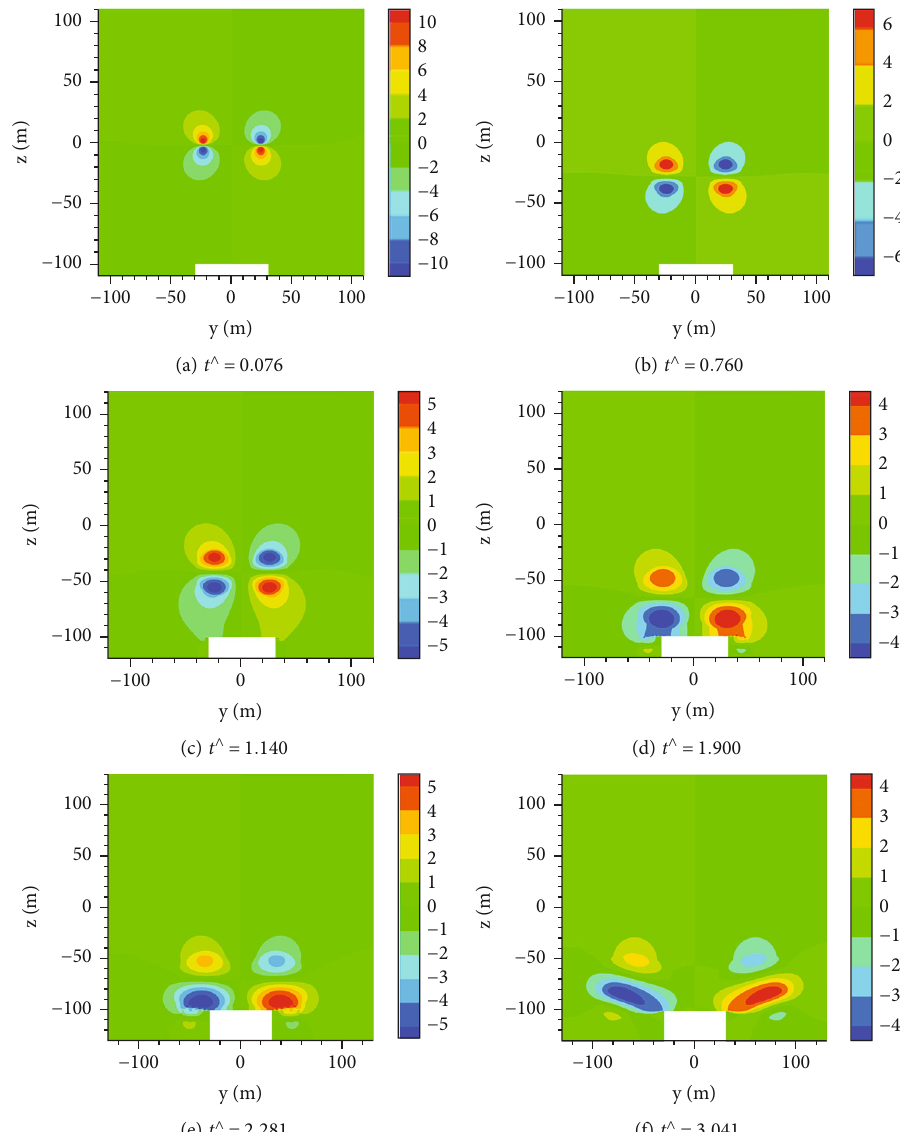
Figure 14: Contours of y velocity at di ff erent times when the wake is 100m above the